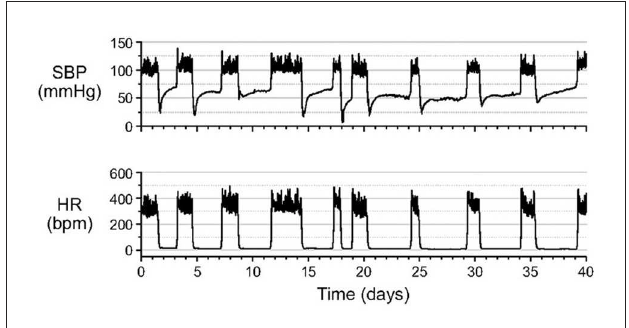
FIGURE2 After entrance into hibernation torpor in Syrian hamsters, systolic blood pressure (SBP) increases to a new plateau at about 50% of euthermic systolic blood pressure (SBP). By contrast, heart rate (HR) remains at a steady minimum throughout the torpor bout. SBP and HR were measured in unanesthetized animals by telemetry with the catheter of a pressure transmitter inserted into the abdominal aorta [Horwitz et al. (33)].